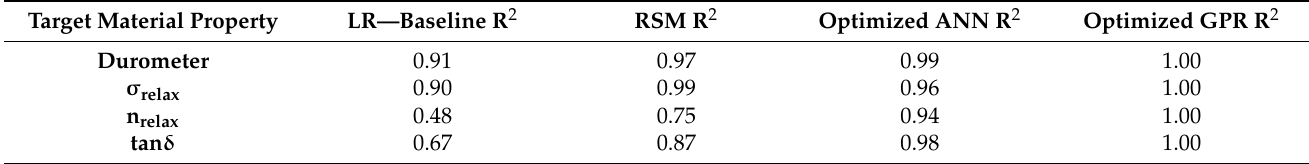
Table 7. Summary of algorithm accuracies presented in this paper ranging in complexity. Target Material